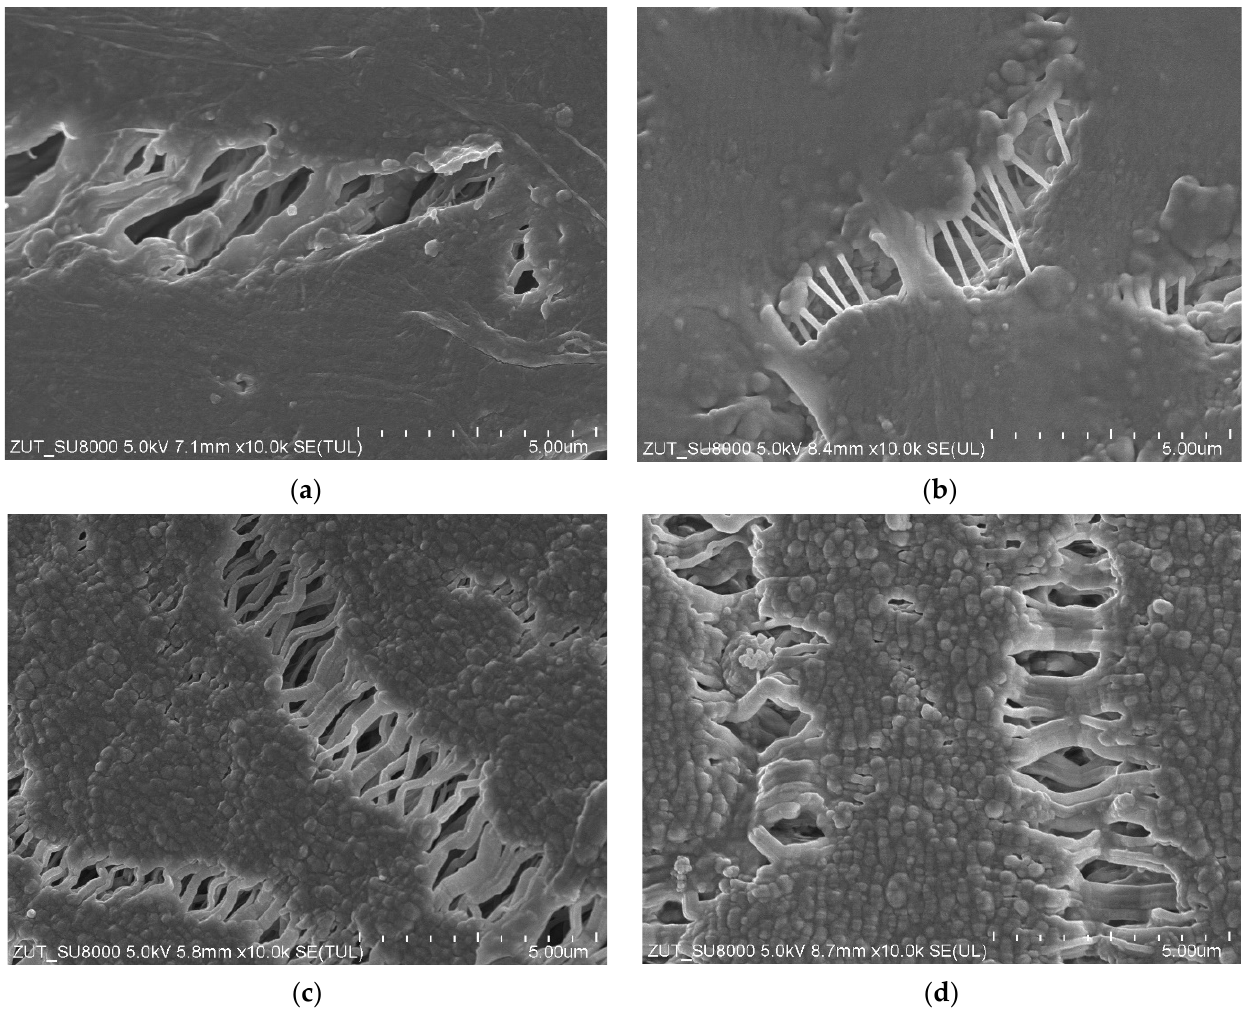
Figure 5. SEM images of the node–fibril structure for virgin and PTFE membrane used for the MD process (2000 h). External surface: ( a ) virgin; ( b ) after MD. Internal surface: ( c ) virgin; ( d ) after MD.